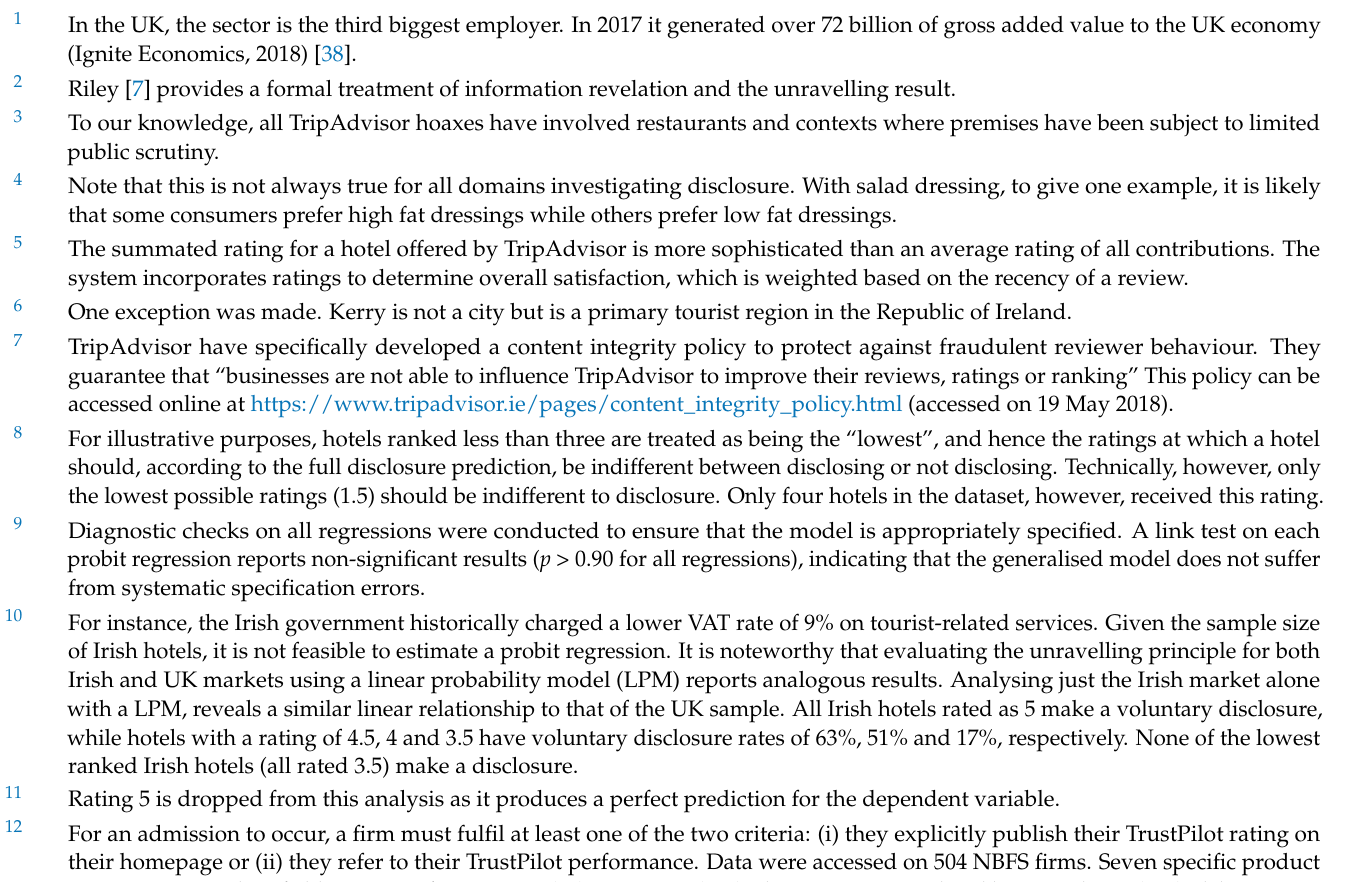
Figure A4. Disclosure ( left ) and nondisclosure ( right ) in the context of holiday